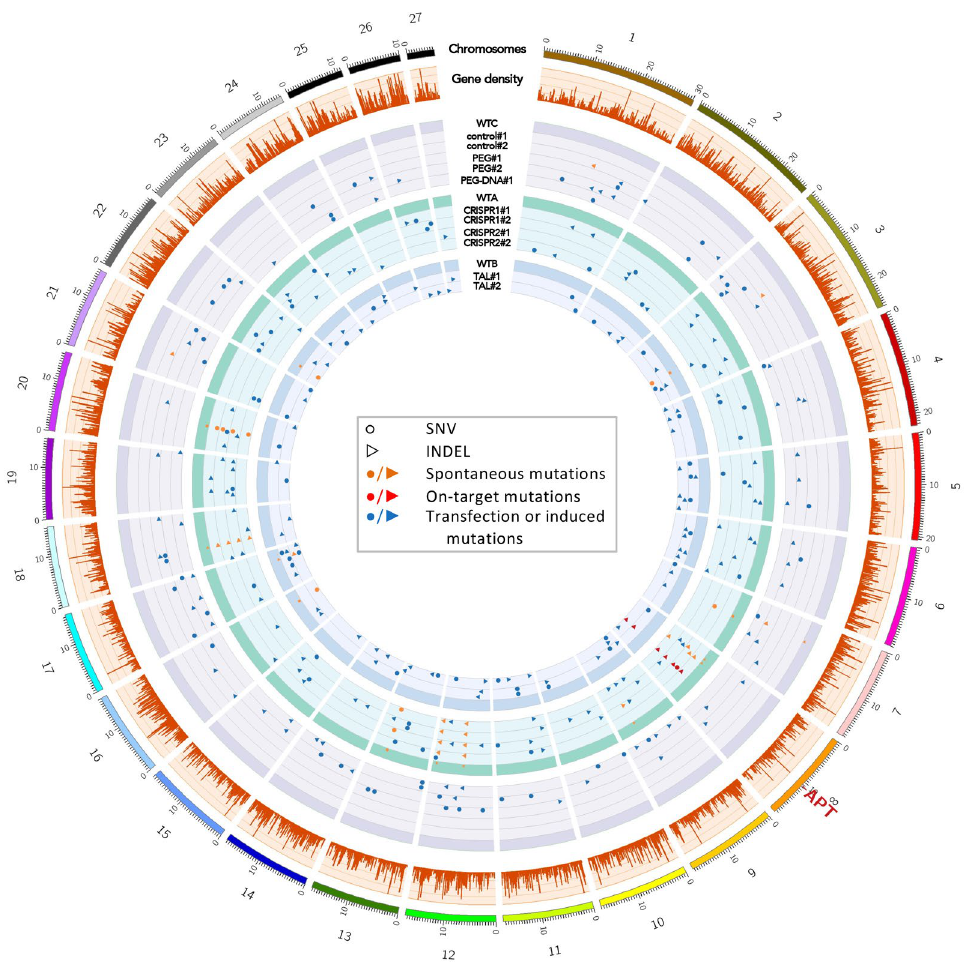
Figure 3. Distribution of spontaneous and transfection mediated mutations. Circos diagram illustrating the distribution along the genome of the different types of mutations detected in the treated plants (SupData 2). The genes affected by these mutations are also illustrated in this Circos. The size of the labels indicates the ratio of variant alleles (AR) in each sample. A large size corresponds to an AR close to 1, and a small size corresponds to an AR at the subclonal level in case of chimeric spontaneous